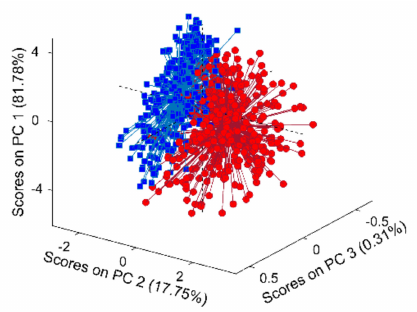
Figure 4. The scores plot of the first three principal components calculated from the original spectra of sweet corn seeds in two cultivars (cultivar H8 in red and H168 in blue), where all samples were linked to the arithmetic mean center of their cultivar cluster by a line.